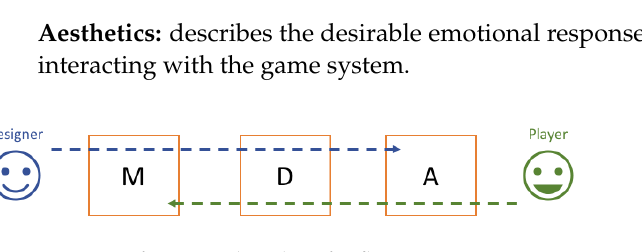
Figure 1. MDA framework order of